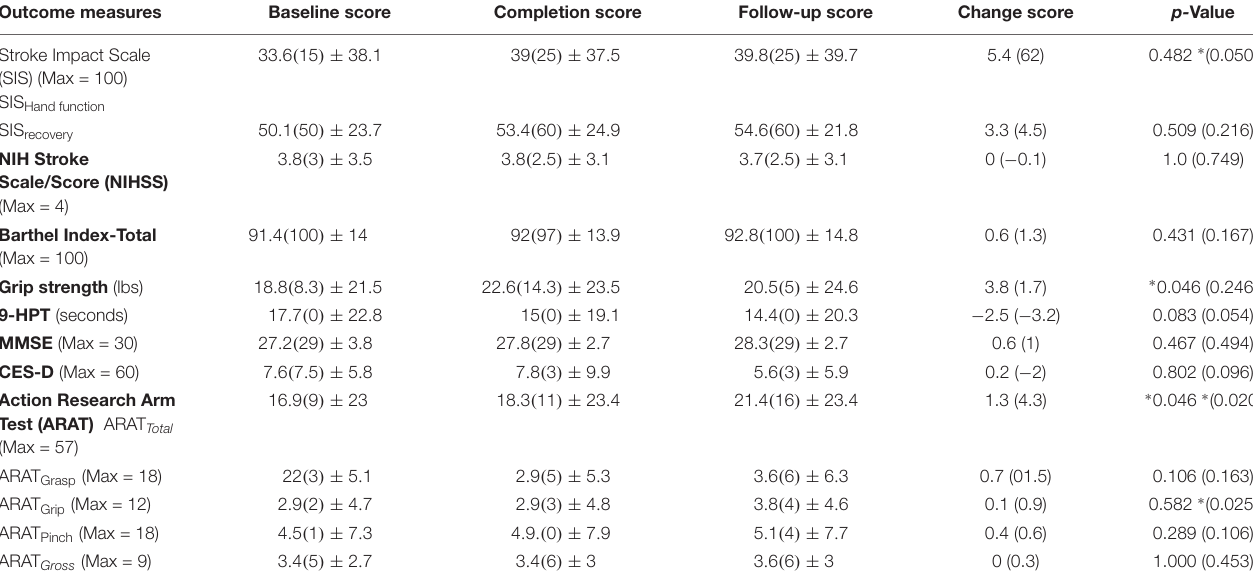
TABLE 2 | Summary of mean outcome measure scores for baseline, completion, and follow-up of the BCI training conditions. Outcome